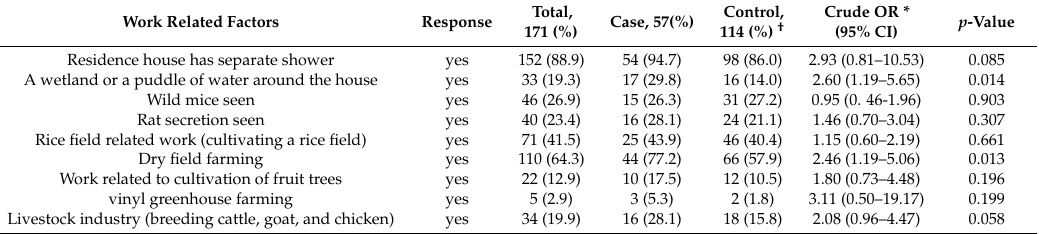
Table 3. Responses of cases and controls to work-related issues possibly associated with scrub